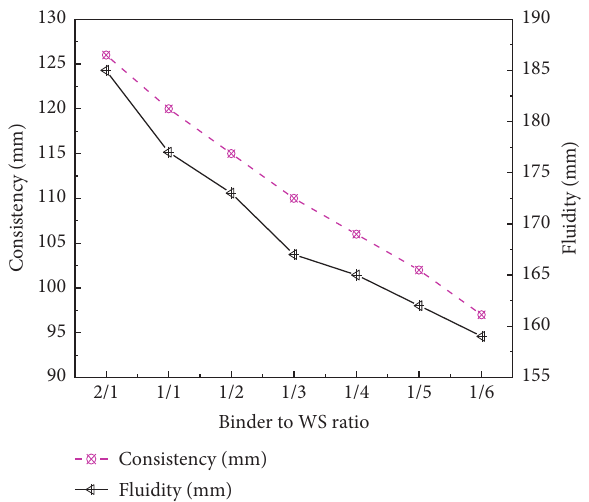
Figure 4: The consistency and fluidity of the waste sediment-based grouting material with different binders to WS ratios.